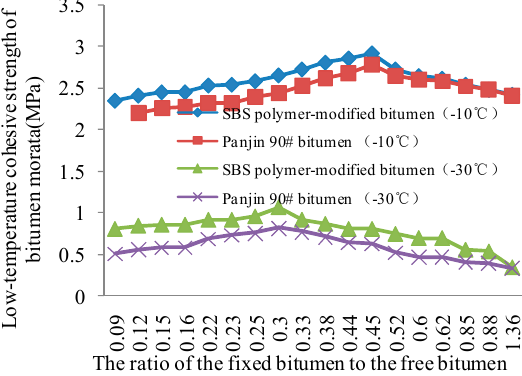
Figure 6. Influence of the fixed bitumen-free bitumen ratio on the low-temperature cohesive strength of bitumen mastics.